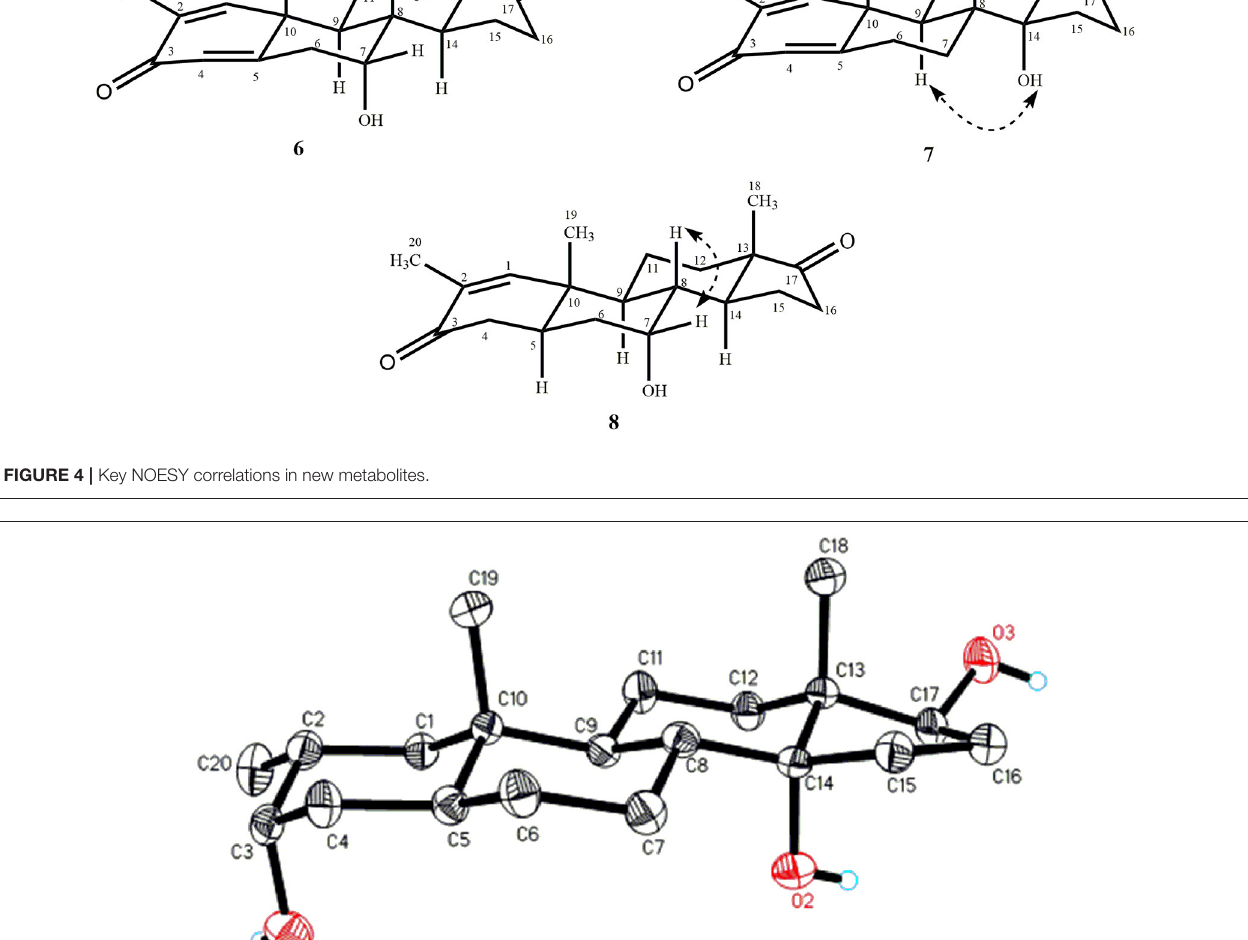
Metabolite 7 , a white solid, displayed the [M + ] in the HREI- MS at m/z 314.1861 (calcd. 314.1882, C 20 H 26 O 3 ), due to